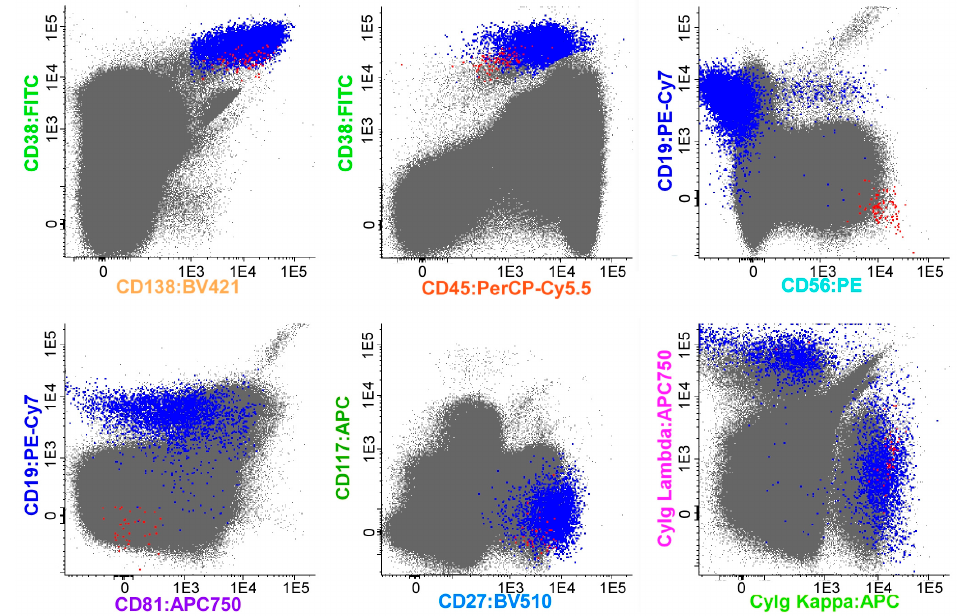
Figure 1. An example of the Next-Generation Flow (NGF) method based on the analysis of (merged) data files corresponding to a bone marrow (BM) sample from multiple myeloma (MM) (>10 7 cells) with low levels of minimal residual disease (MRD), stained with the NGF-MM MRD panel. The figure shows bivariate dot plot representations in which plasma cells (PCs; blue and red dots) were gated using a conventional manual analysis strategy. Normal PCs (blue dots) display characteristic normal patterns of expression for the surface membrane markers used with a cytoplasmic (Cy) Ig κ vs. CyIg λ ratio of 1.3. In contrast, clonal/aberrant PCs (red dots) can be clearly discriminated from normal PCs based on their more homogeneous phenotypic profile, the presence of myeloma-associated phenotypes (CD138hi, CD38dim, CD19-, CD81-, CD117-, and CD27dim), and a restricted pattern of expression of CyIg κ . Other non-PC BM populations are depicted as gray dots. Please note that, in this sample, PCs corresponded to 0.06% of all nucleated BM cells; in turn, aberrant PCs corresponded to 0.0007% of the whole BM cellularity, with an assay sensitivity (in the quantitative range) of <5 × 10 − 6 .